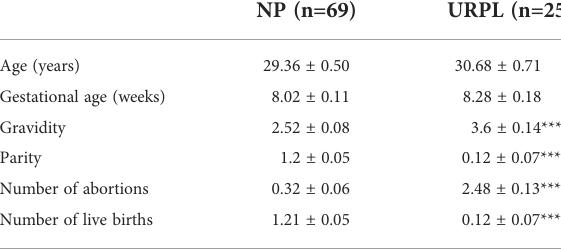
TABLE 1 Demographics and clinical characteristics of the